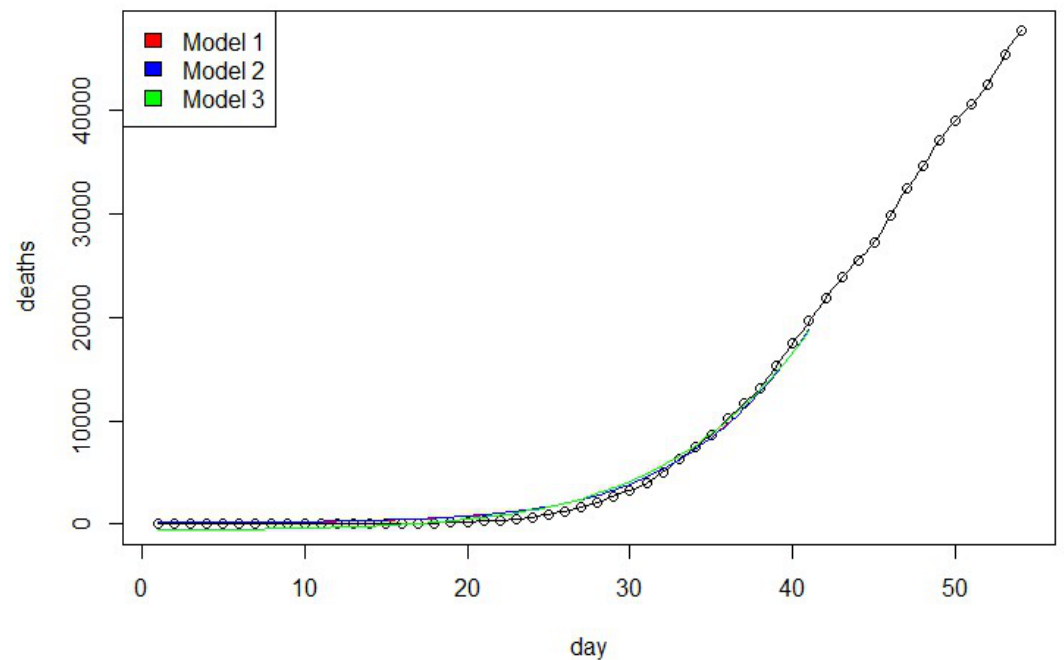
Figure 4. The estimated cumulative number of deaths vs. actual death data from all three models.